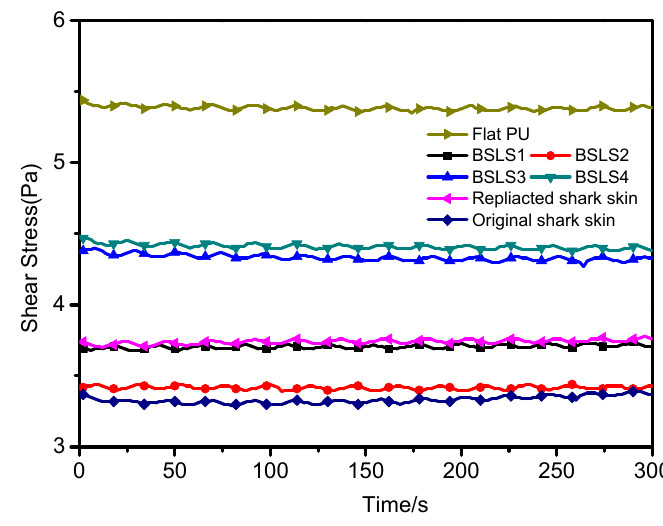
Figure 7. The shear stress for different samples.